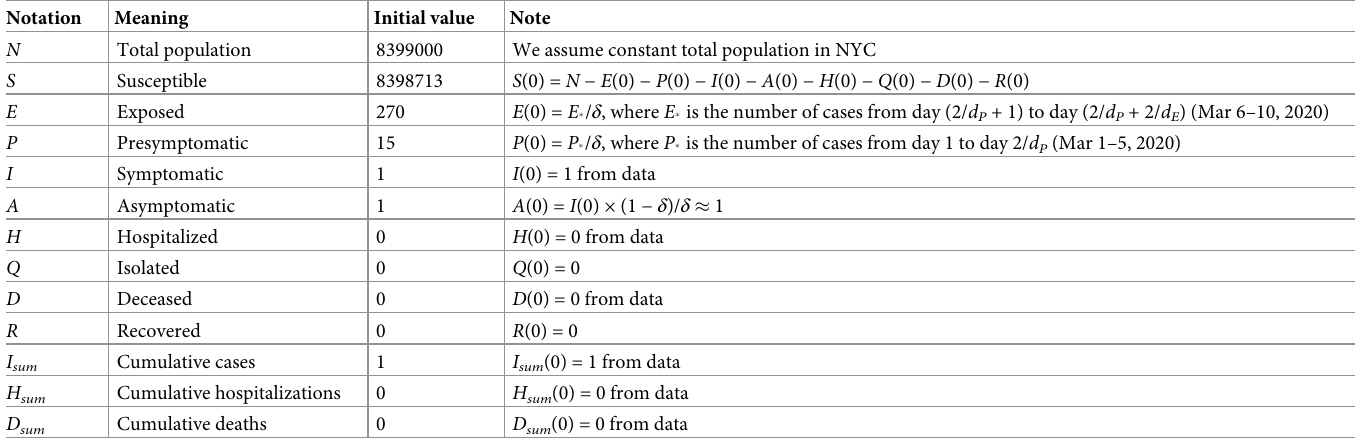
Table 1. Notations and initial values for the model in Fig